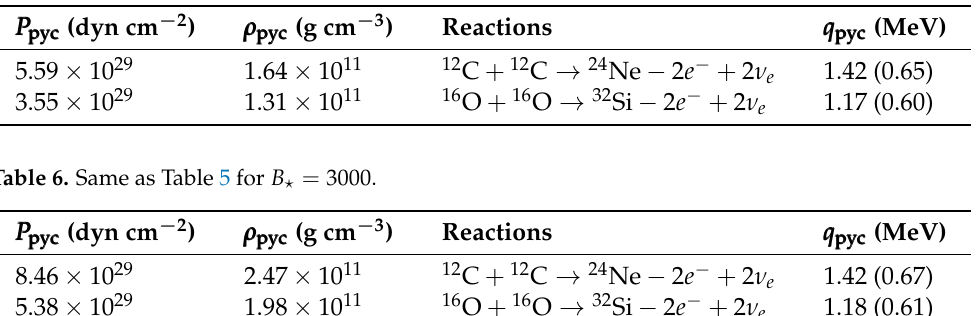
Table 5. Maximum possible heat released q pyc per nucleon (in MeV) from pycnonuclear fusion followed by electron captures in the outer crust of a magnetar with B (cid:63) = 2000. The numbers in parentheses indicate the contributions from the sole fusion. The pressure P pyc (in dyn cm − 2 ) and density ρ pyc (in g cm − 3 ) at which fusion occurs were fixed by the onset of electron captures considering ground-state-to-ground-state transitions.